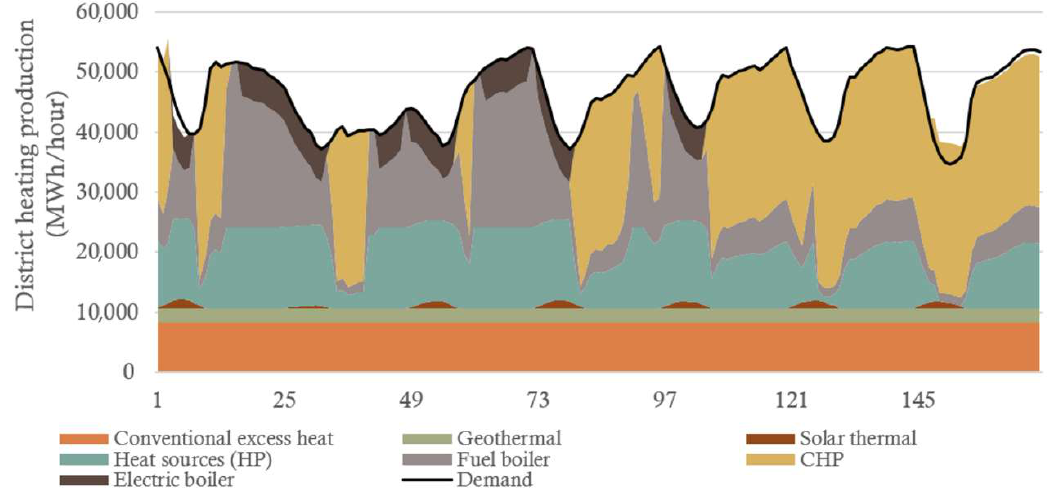
Figure 7. District heating production in Germany for a week in February from the 2050 scenario.